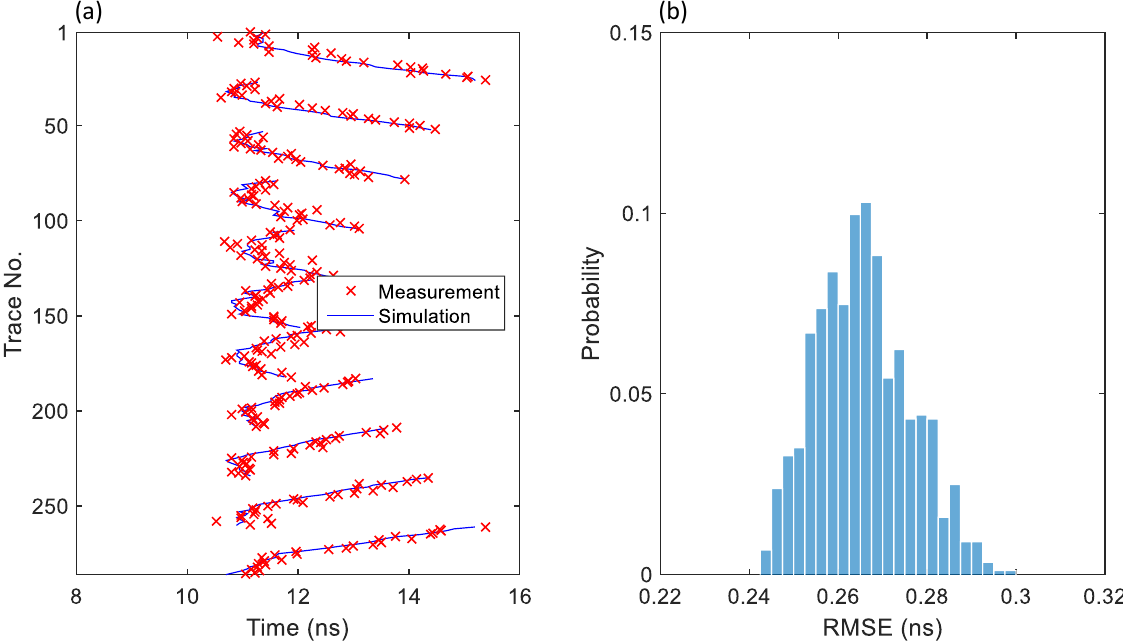
Figure 7. Fitting of the measurement data by the posterior models derived from Bayesian inversion using the FDTD forward model: ( a ) measured and simulated first-arrival traveltimes, and ( b ) histogram of the RMSE values of the posterior